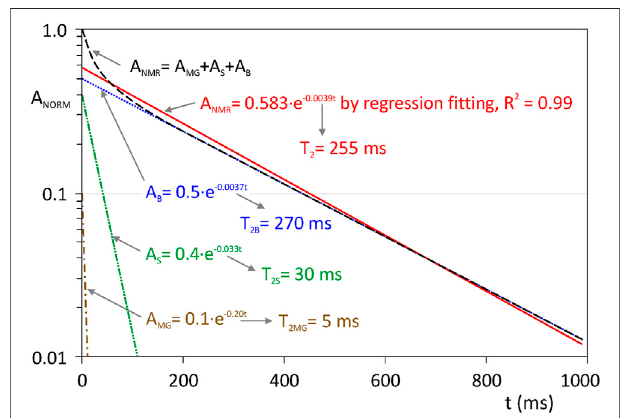
FIGURE 4 | Plot of three mono-exponential functions corresponding to the bulk, surface and diffusion relaxation, together the total signal (sum of three). – · – · – Diffusion relaxation ( I MG (cid:1) 0.1, T 2MG (cid:1) 5 ms); – ·· – ·· –